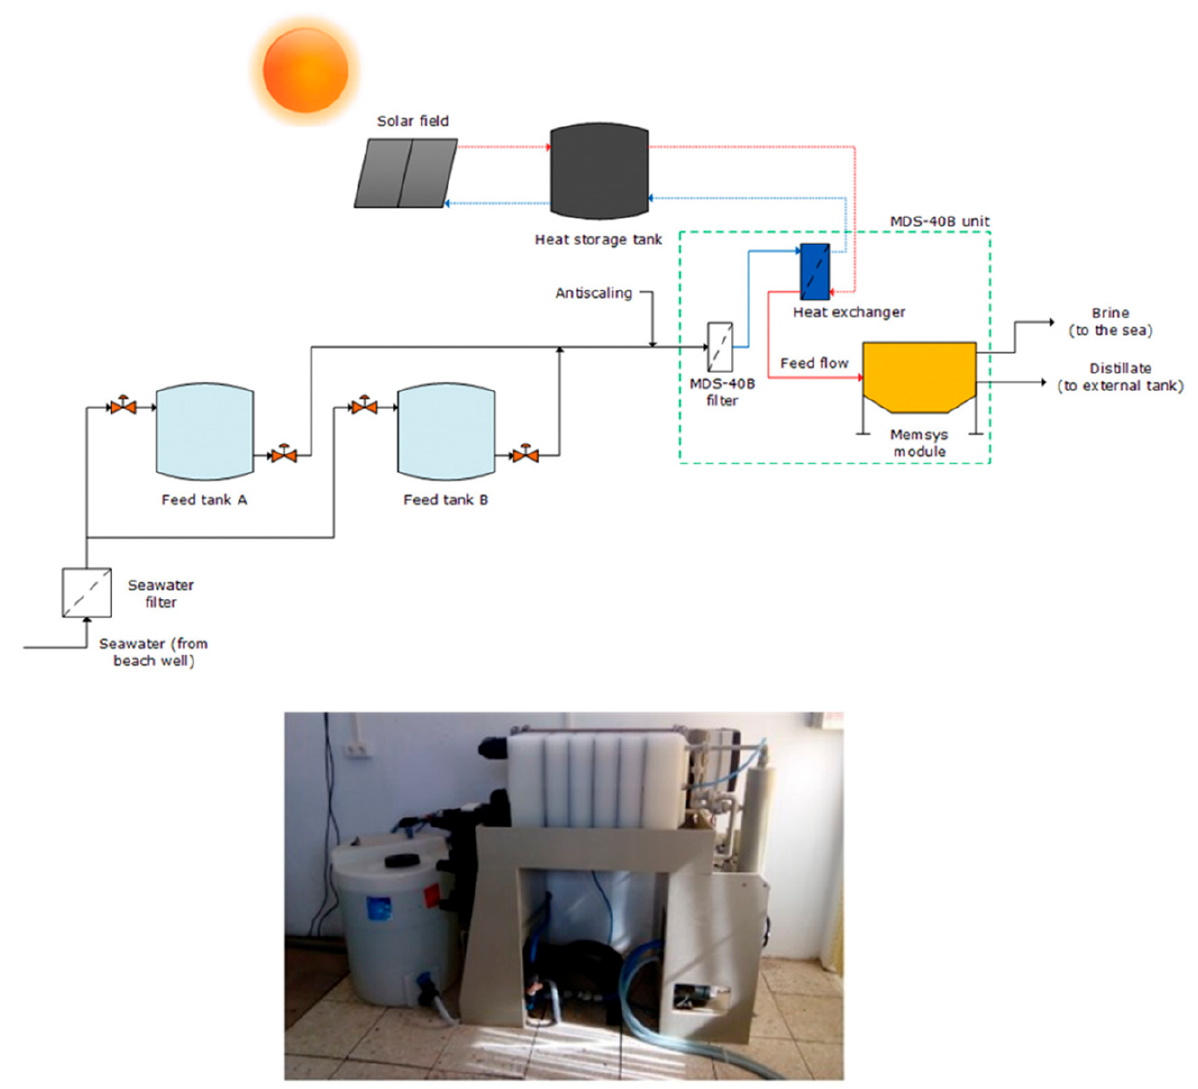
Figure 19. Diagram showing the main components of the seawater desalination pilot plant and Aquaver’s prototype. Reprinted from [117]. Copyright (2020) with permission from Elsevier.